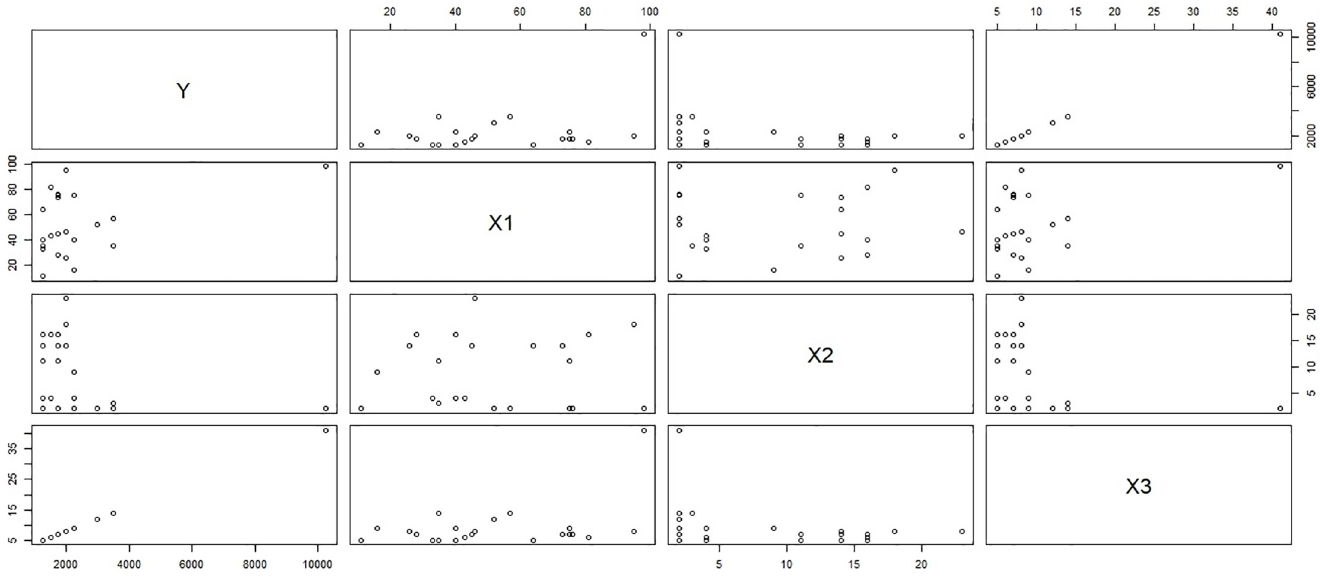
Fig 1. Behavior of non-respondents with λ 2 = 0.4.